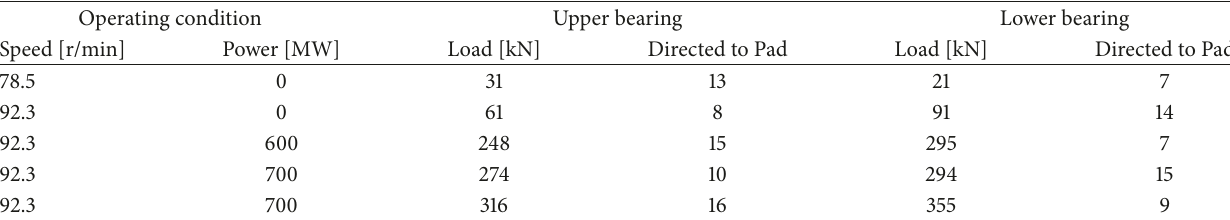
Figure 2: Transducers arrangement in the lower journal bearing. Table 1: Radial static loads measured in the journal bearings of an